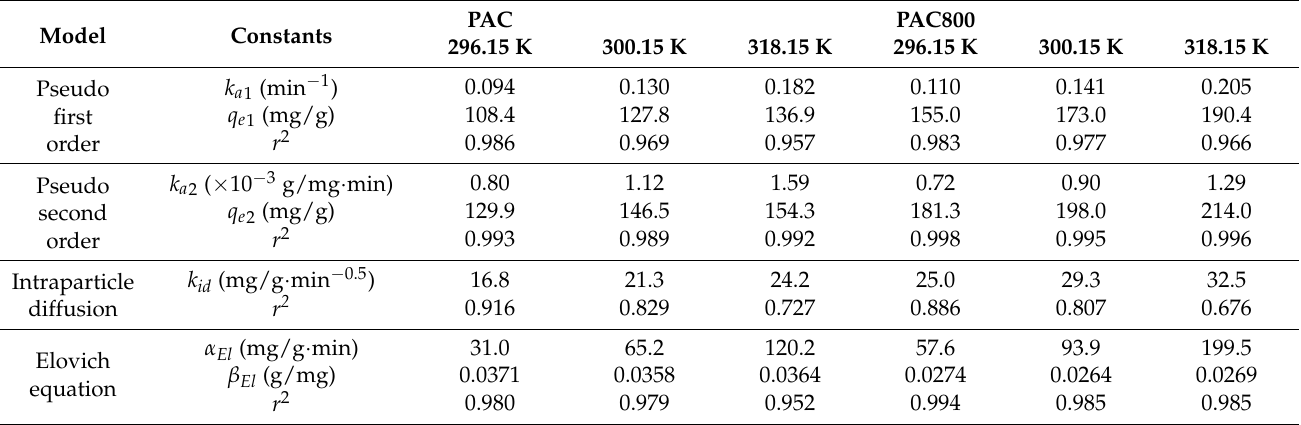
Table 3. Results of adsorption kinetics.